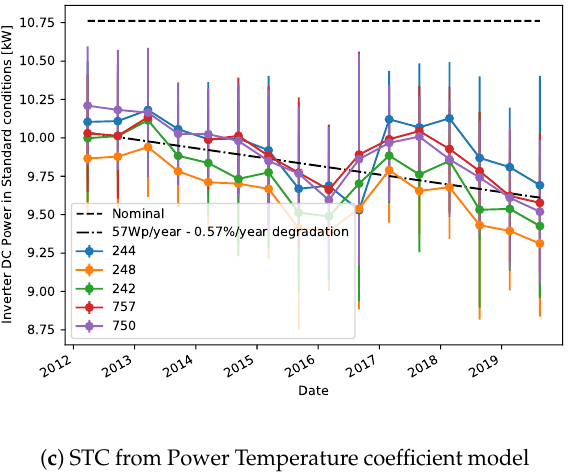
( c ) STC from Power Temperature coefficient model Figure 5. Predicted reference power for plant C.